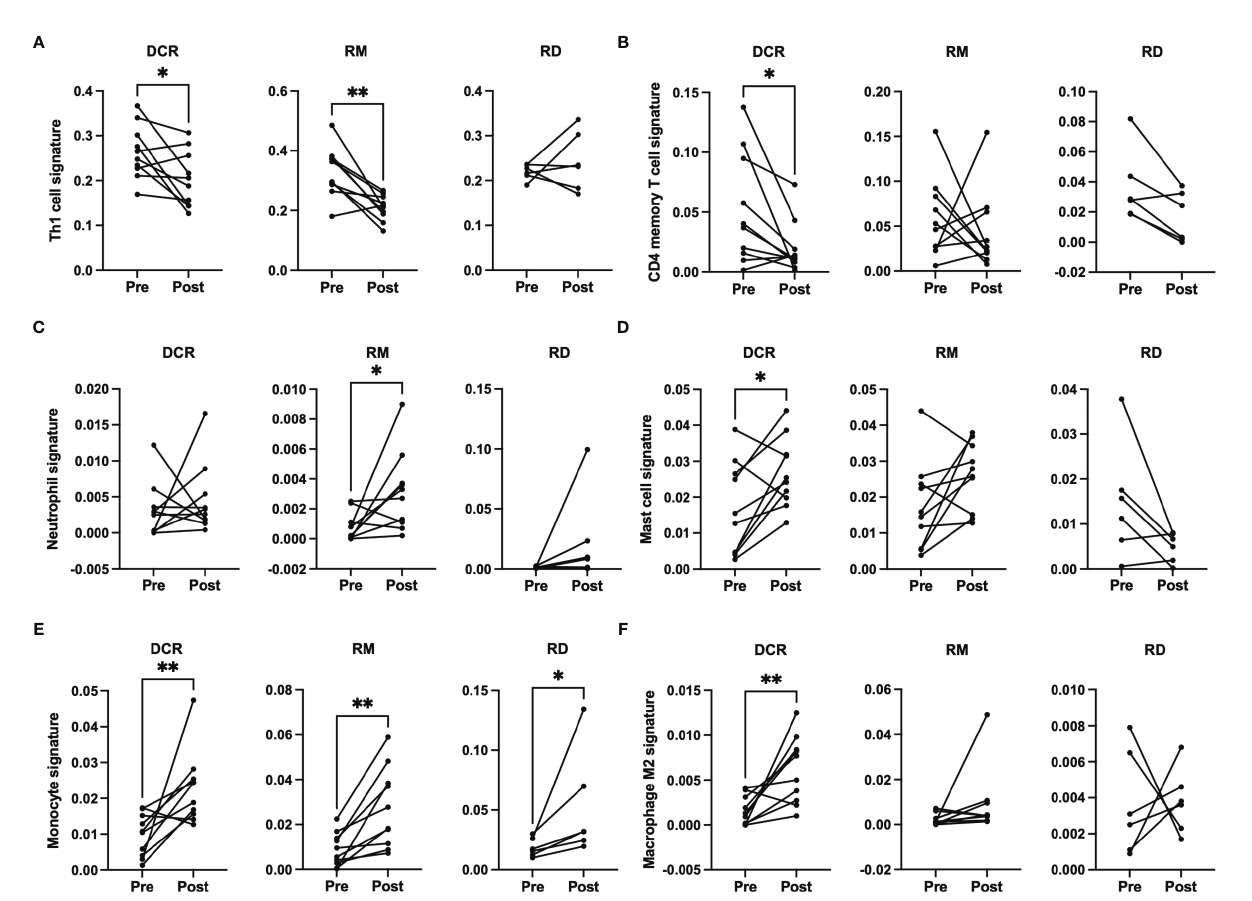
FIGURE 5 | xCell based immune phenotype signature scores for (A) Th1 cells, (B) CD4 memory T cells, (C) neutrophils for RM, (D) mast cells, (E) monocytes and (F) M2 macrophages. * indicates p < 0.05, ** inidcates p <